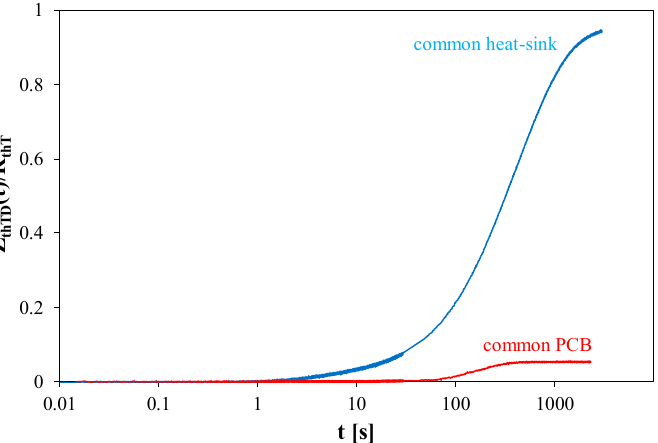
Figure 9. Waveforms of the transfer transient thermal impedance between the transistor and the diode normalized to thermal resistance of the transistor for different cooling conditions.